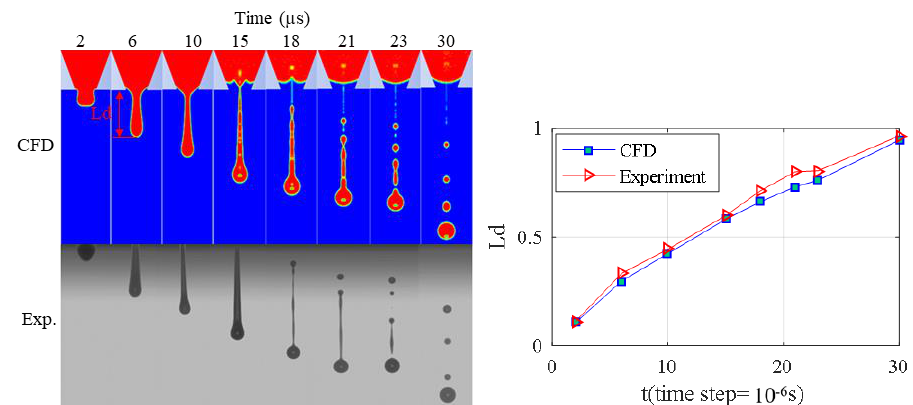
Figure 7. CFD model experiment verification.